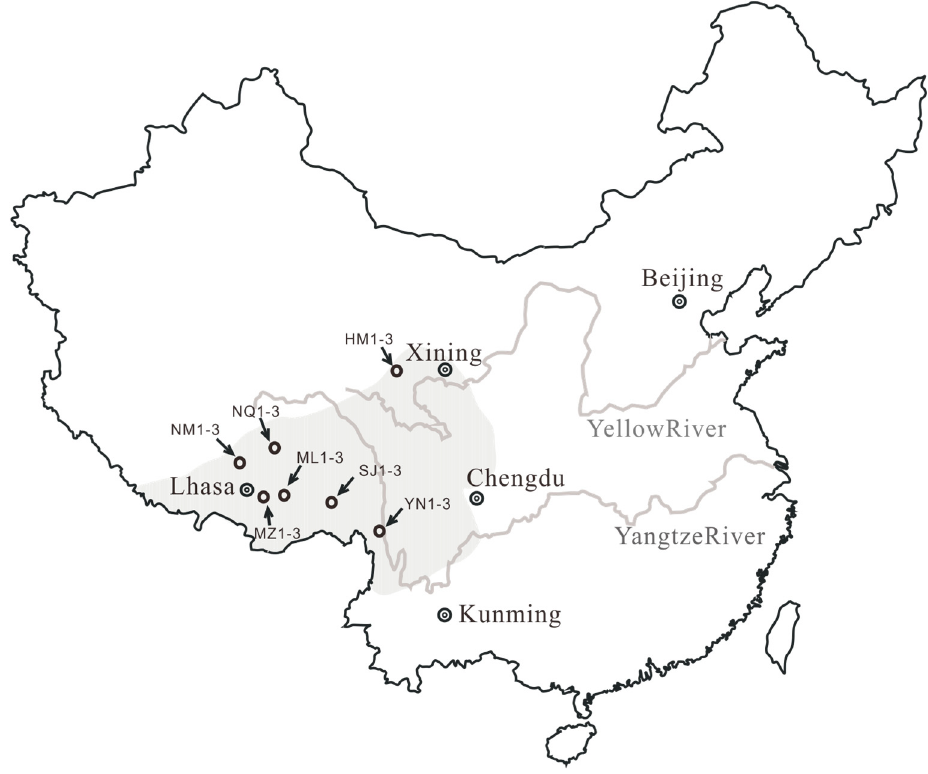
Figure 1. Schematic diagram illustrating the habitats of wild Ophiocordyceps sinensis in China (shadow area) and the sampling locations.